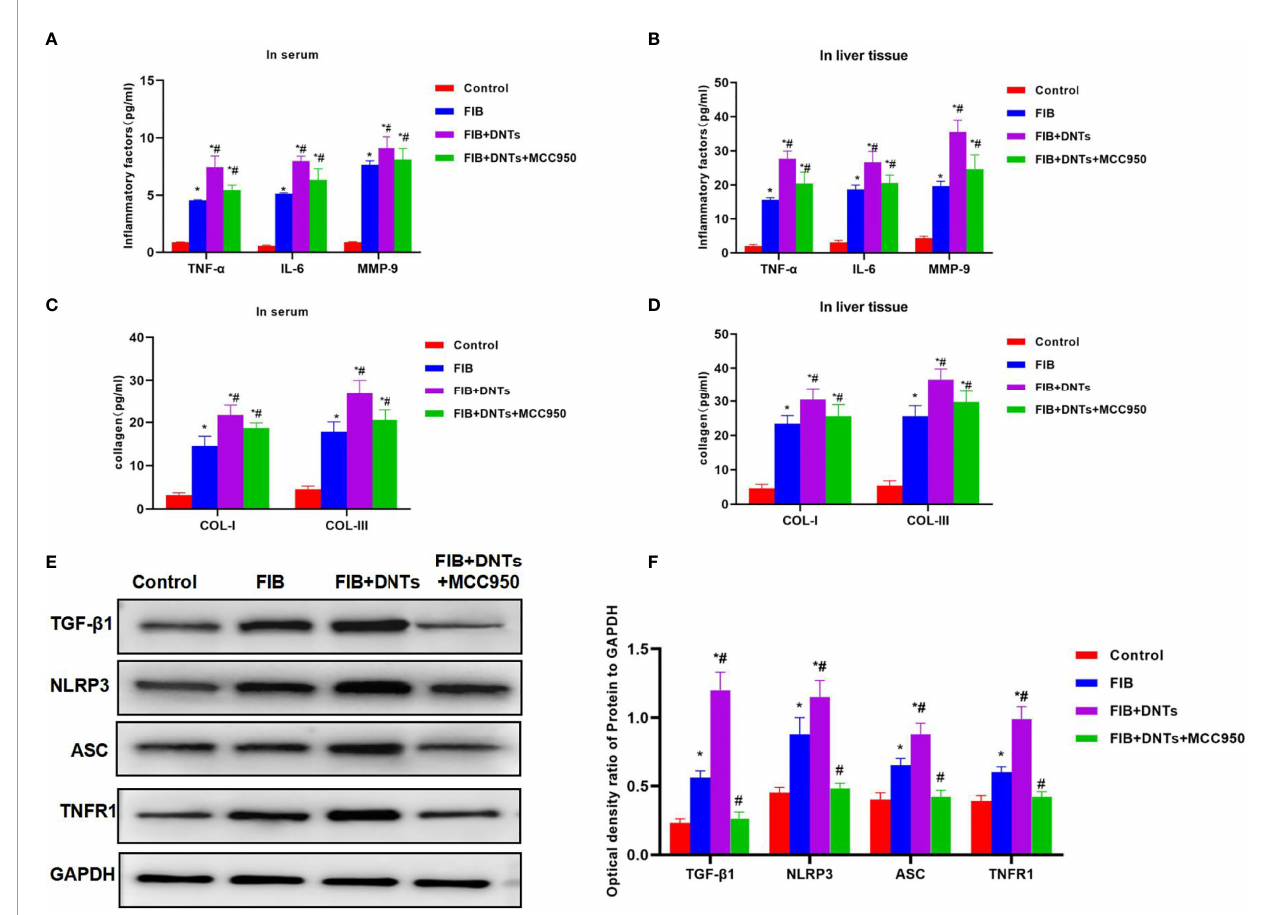
FIGURE 7 | Effect of DNTs on collagens, in fl ammatory factors, and NLRP3 in fl ammasome in mice with liver fi brosis. (A, B) The expression of in fl ammatory factors in peripheral blood and hepatic tissues of FIB group signi fi cantly increased; DNTs further promoted the expression of in fl ammatory factors, which was signi fi cantly higher than that of FIB group. MCC950 decreased the expression of in fl ammatory factors. *p < 0.05 compared with control group, # p < 0.05 compared with FIB group. (C, D) Expression of COL-1 and COL-III in peripheral blood and hepatic tissues of mice with liver fi brosis was signi fi cantly higher than that in control group, while DNTs further promoted collagen expression. *p < 0.05 compared with control group, # p < 0.05 compared with FIB group. (E, F) Expression of NLRP3 and TNFR1 increased in FIB, DNTs further promoted their expression, and MCC950 reduced their expression. *p < 0.05 compared with control group, # p < 0.05 compared with FIB group. DNTs, double-negative T